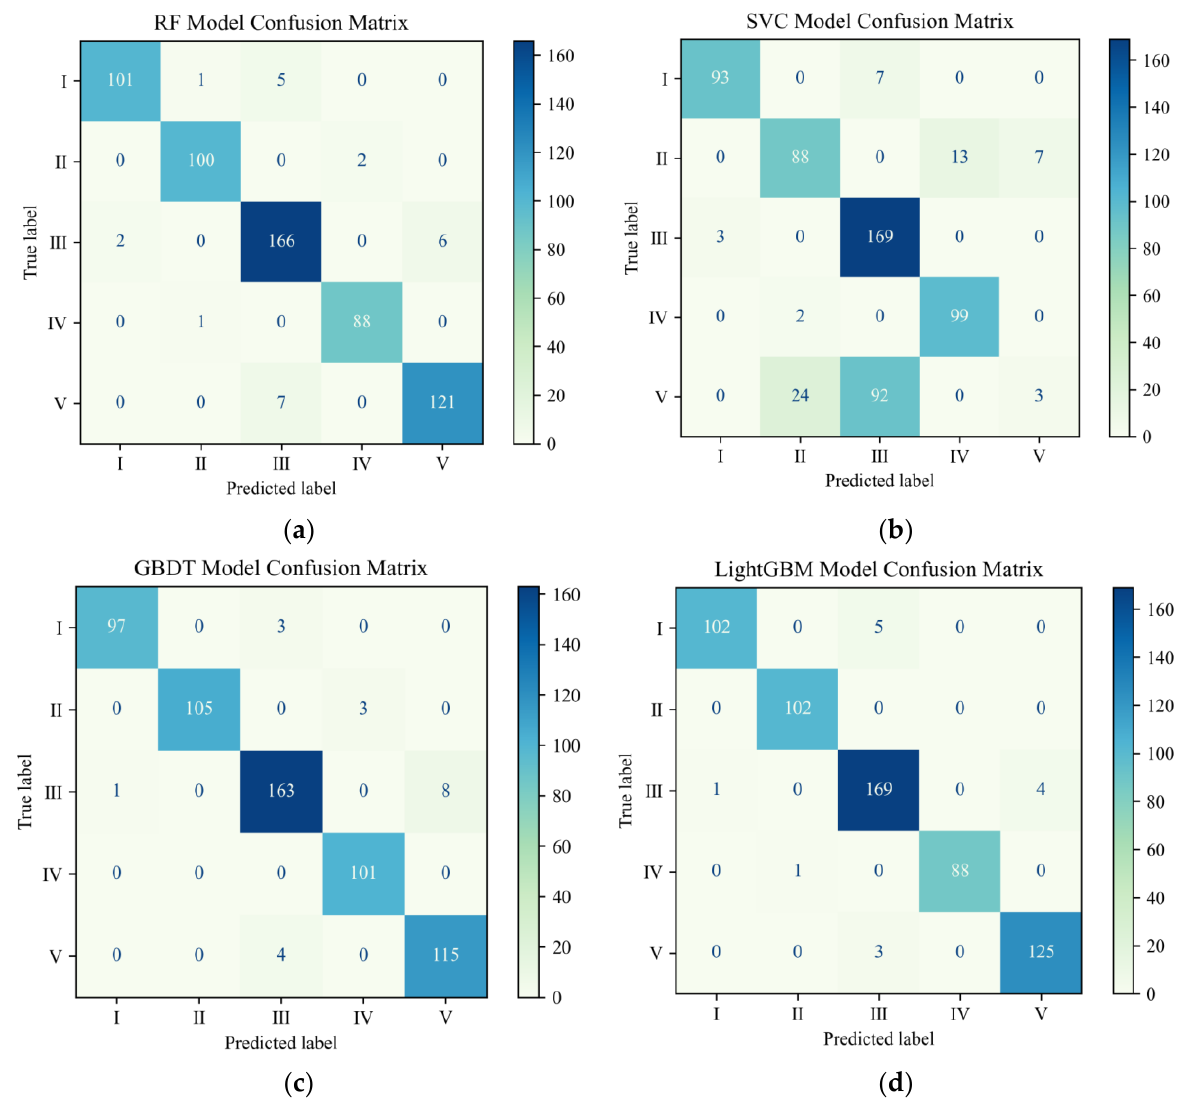
Figure 16. Confusion matrices of different models. ( a ) Confusion Matrix of RF Classifier. ( b ) Confusion Matrix of SVM Classifier. ( c ) Confusion Matrix of GBDT Classifier. ( d ) Confusion Matrix of LightGBM Classifier.